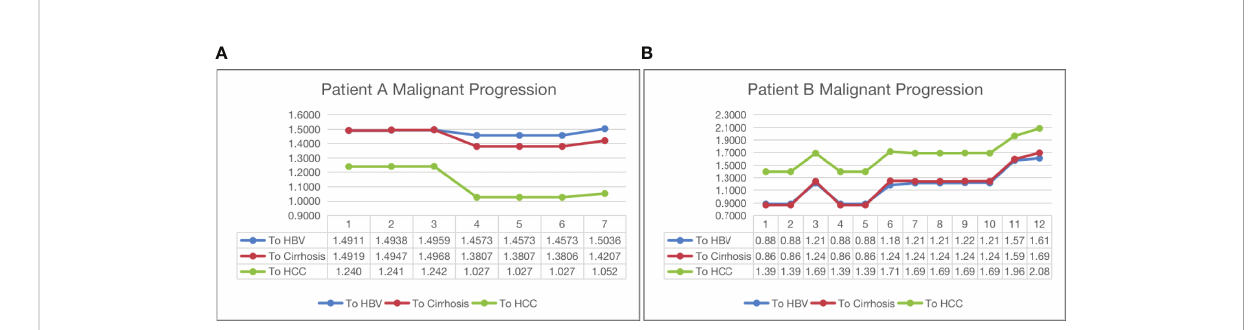
(cid:129) Figure 5-(a) plots the learning curve, which shows the training and CV scores as more instances are utilized in training. It can be seen that the training score reached 1.0 with only 400 training samples, while the CV score was less than 0.9 with the same number of training instances. As more samples participated in training, the training - CV score gap narrowed down, posting a CV score of 0.95, which partially addressed the over fi tting issue. (cid:129) The ROC curves and the calculated AUCs are shown in Figure 5-(b). Five curves, including the ROC curves for each individual class, the micro and macro-average ROC curves, along with the corresponding AUC scores, are reported. Since each ROC curve plots TPR vs. FPR at various classi fi cation thresholds, AUC is threshold- invariant. An ideal ROC curve stays to the top left area of the chart, yielding an AUC score close to 1.0. In